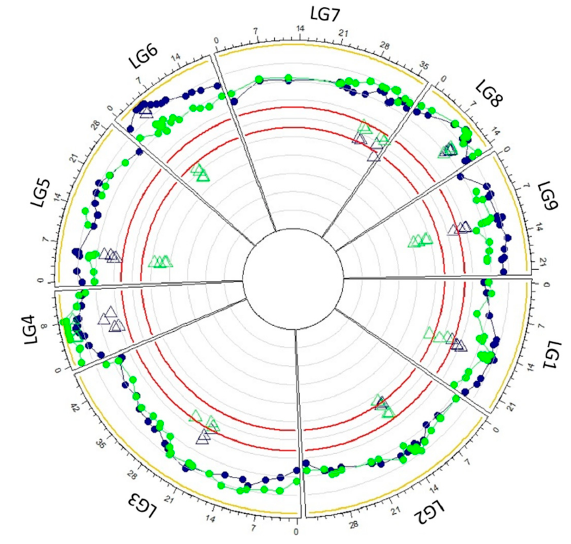
Figure 6. Parental heterozygosity restitution by diploid gametes (circle) and preferential chromosome pairing (triangle) for tetraploid citrumelo (blue) and citrandarin (green). Red line: limit of the range of PHR variation in the case of full tetrasomy (between 0.66 with no double reduction and 0.55 in the case of maximum double reduction); Yellow line: PHR = 1, in the case of complete disomic